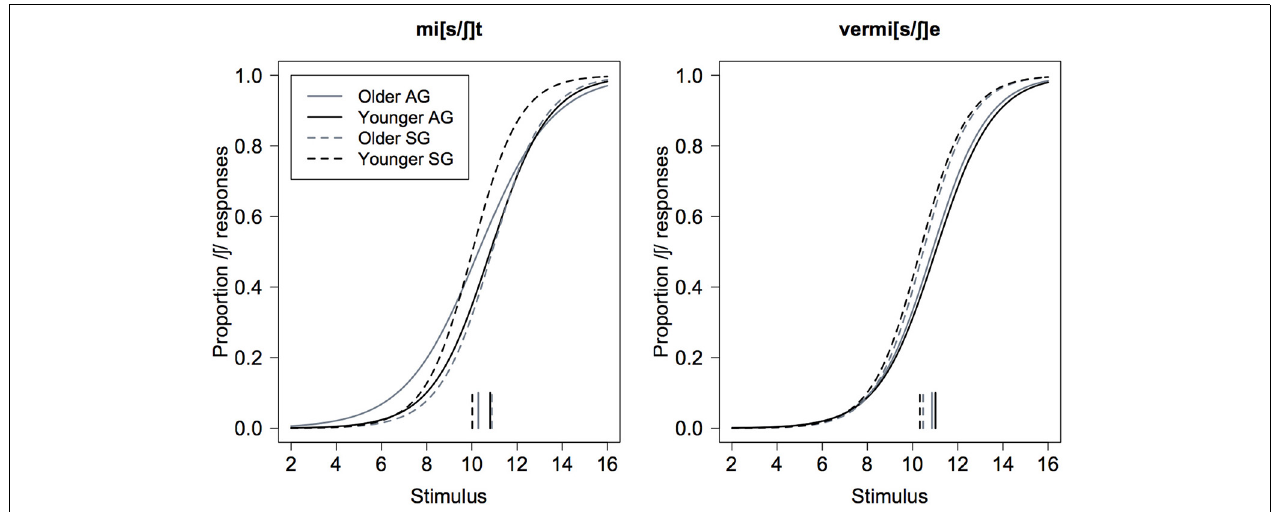
(cid:2) listeners, and for older (gray) and younger (black) listeners. The vertical / responses as a (cid:2) (cid:2) (cid:2) lines at the bottom of the display are the decision boundaries for which the ]t (left) and vermi[s/ ]e / responses are equiprobable (and equal to /s/ and /